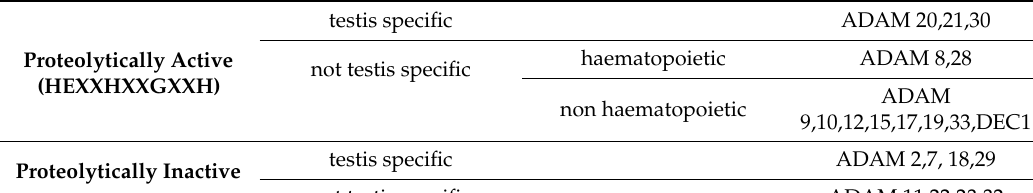
Table 1. Classification of the human ADAM protease family.